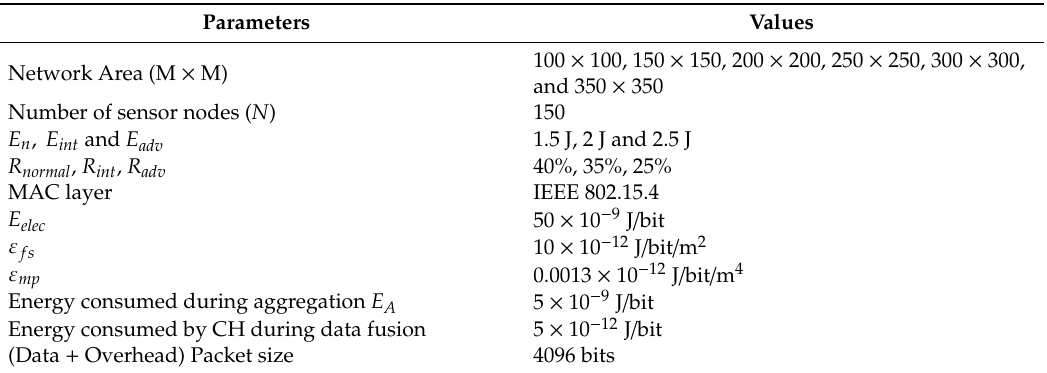
Table 8. Simulation